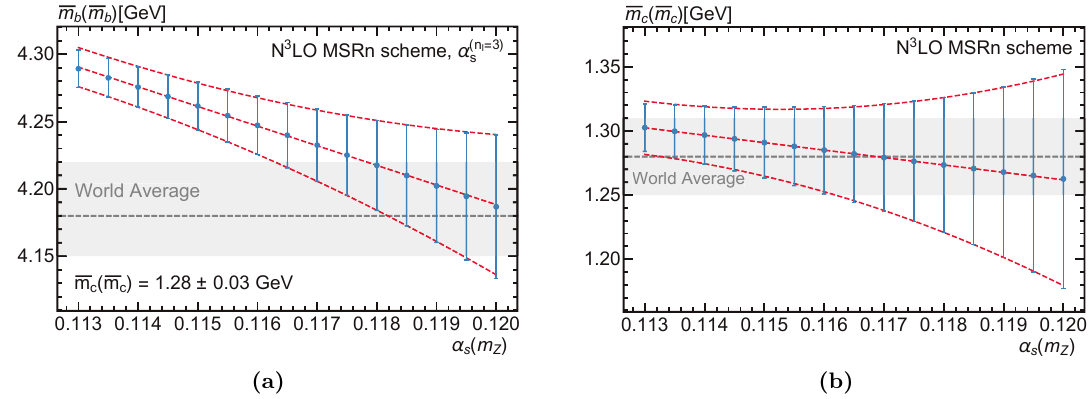
Figure 10. Dependence of the bottom (left panel) and charm (right panel) quark masses on the value of (cid:11) ( n f =5) s ( m Z ). The determinations correspond to global (cid:12)ts for the n = 1 ; 2 (bottom) and n = 1 (charm) states. The MSRn scheme is used at N 3 LO order, in both cases in terms of (cid:11) ( n ‘ =3) s